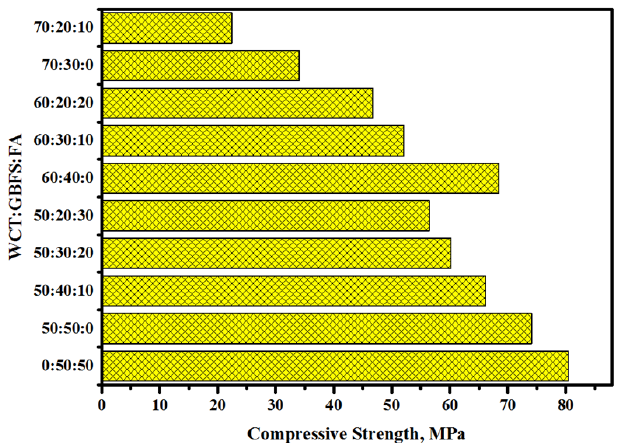
Figure 1. CS development in GPMs incorporated with WCT, GBFS, and